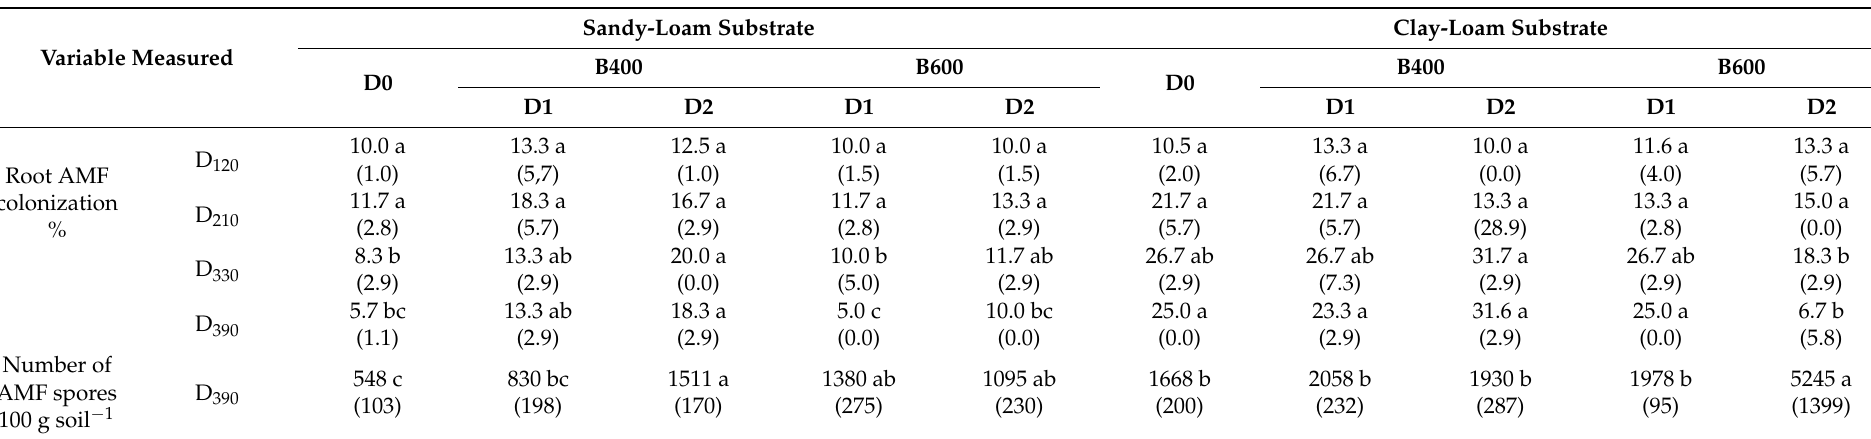
Table 2. Effect of biochar addition on root AMF colonization and number of AMF spores (final pyrolysis temperature of biochar B400—400 ◦ C and B600—600 ◦ C; application